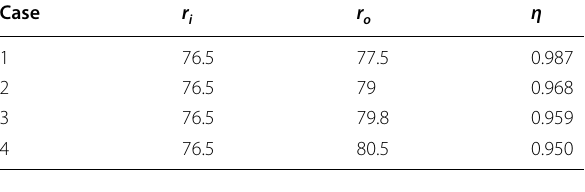
Table 2 Parameters of TCP flow with different radius ratios Case r i